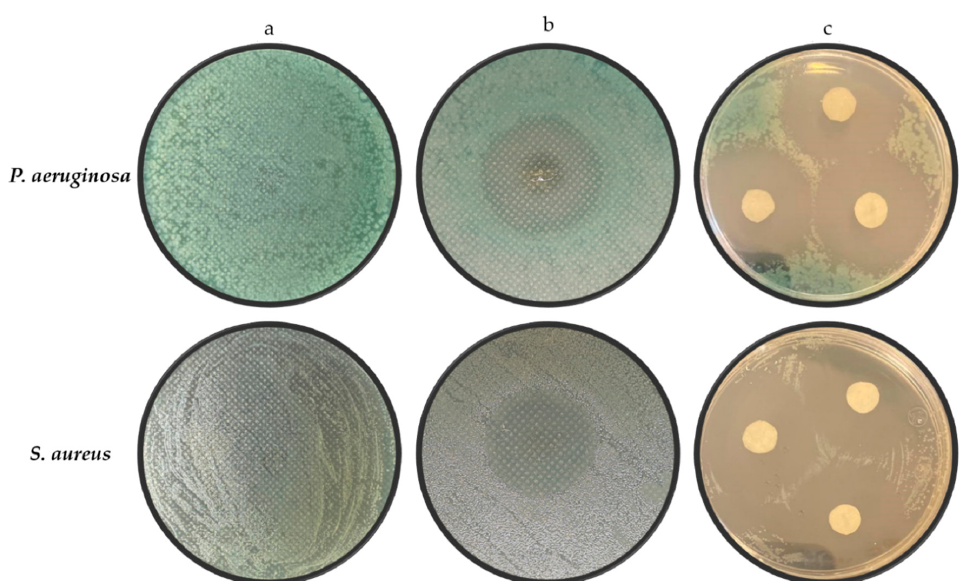
Figure 7. Inhibition halos observed in the bacteria cultures due to the presence of the different treatments: ( a ) negative control using scaffold samples without gentamicin, ( b ) cultures incubated with scaffold sample and ( c ) positive control with gentamicin disks.